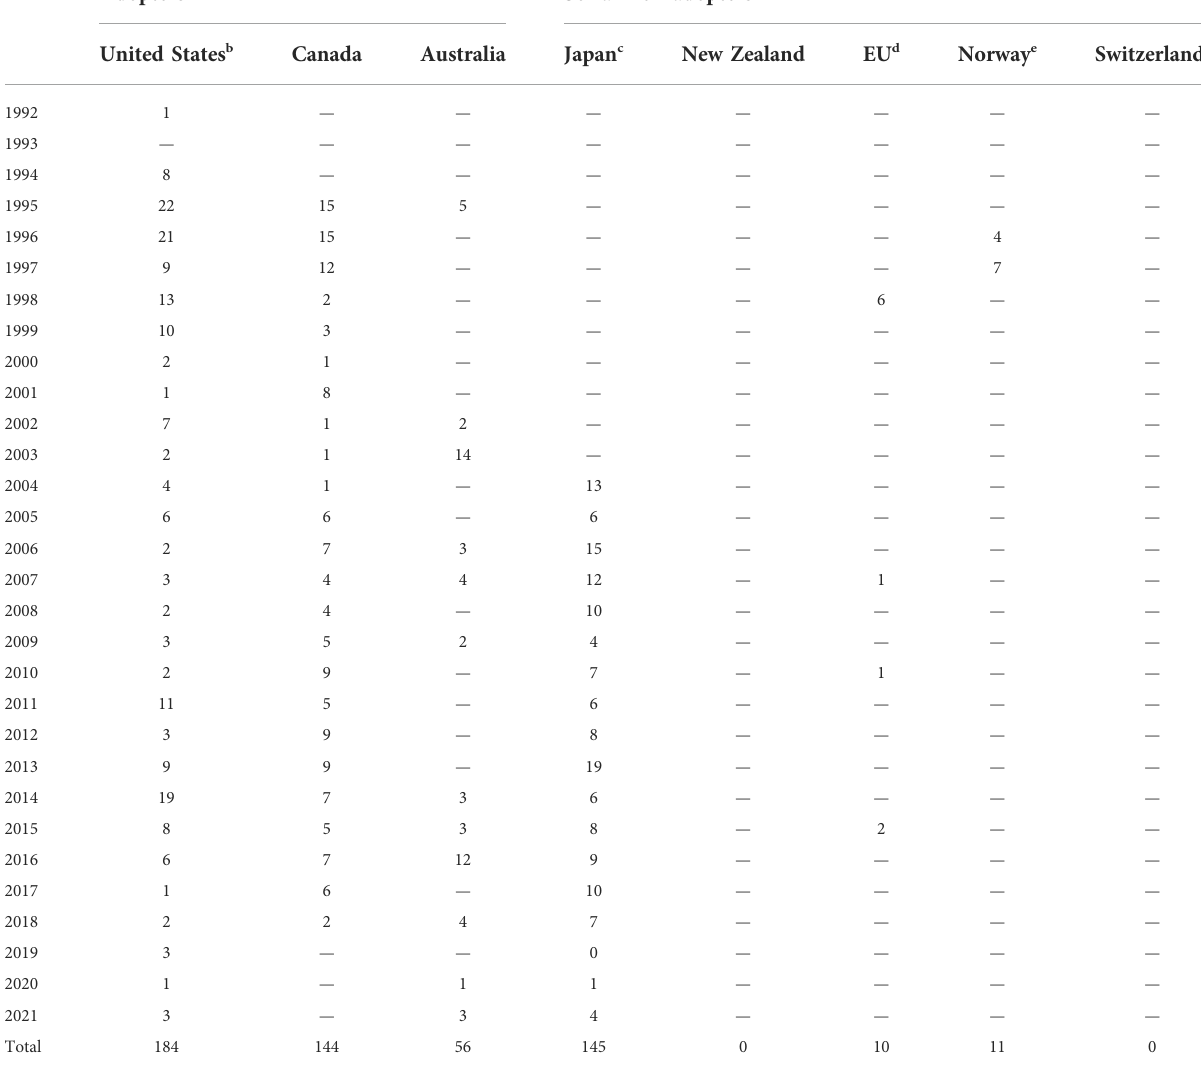
TABLE 2 Number of GM plant events authorised for commercial cultivation per year per jurisdictions. Source: ISAAA (2021). Adopters a So-far non-adopters a